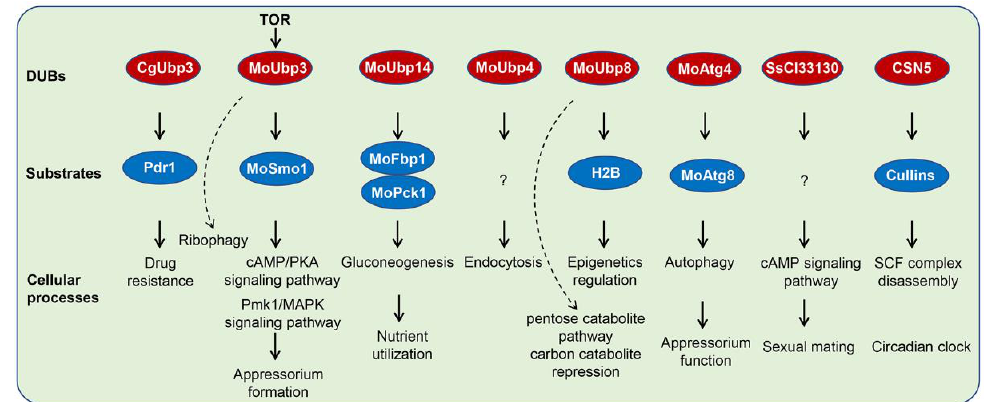
Figure 3. Regulatory mechanisms of DUBs in pathogenic fungi.